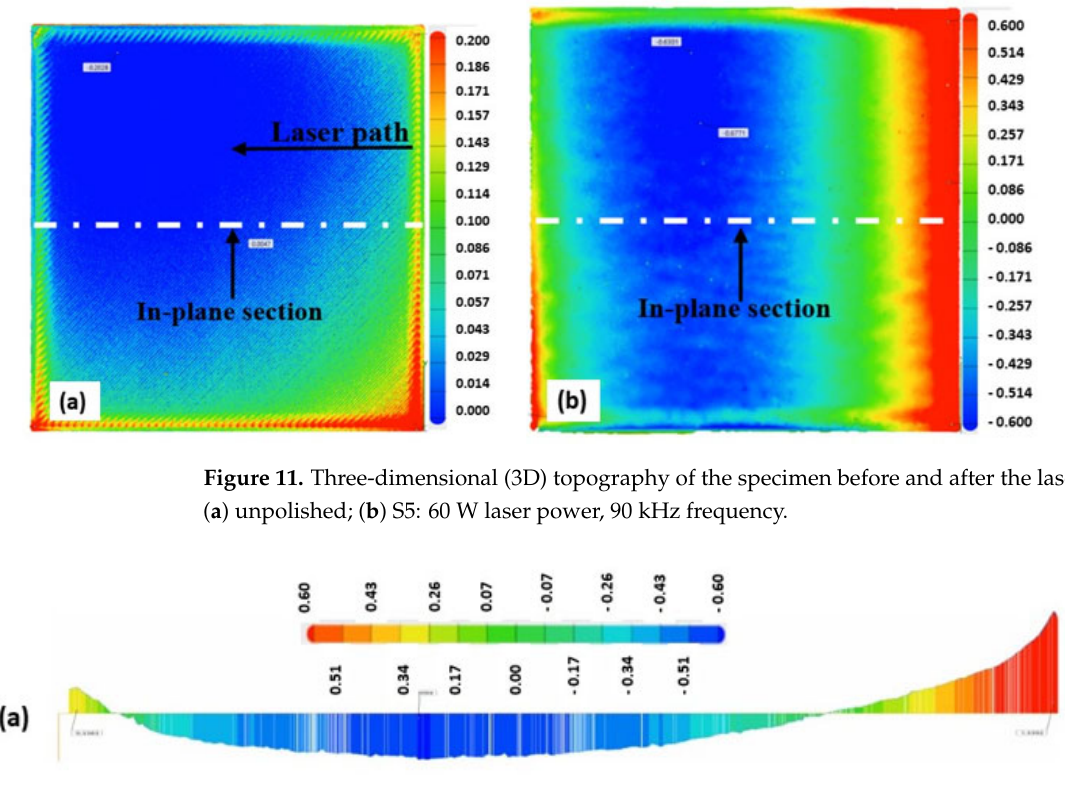
Figure 10. In ‐ plane section view of S1; ( a ) before and ( b ) after laser polishing.